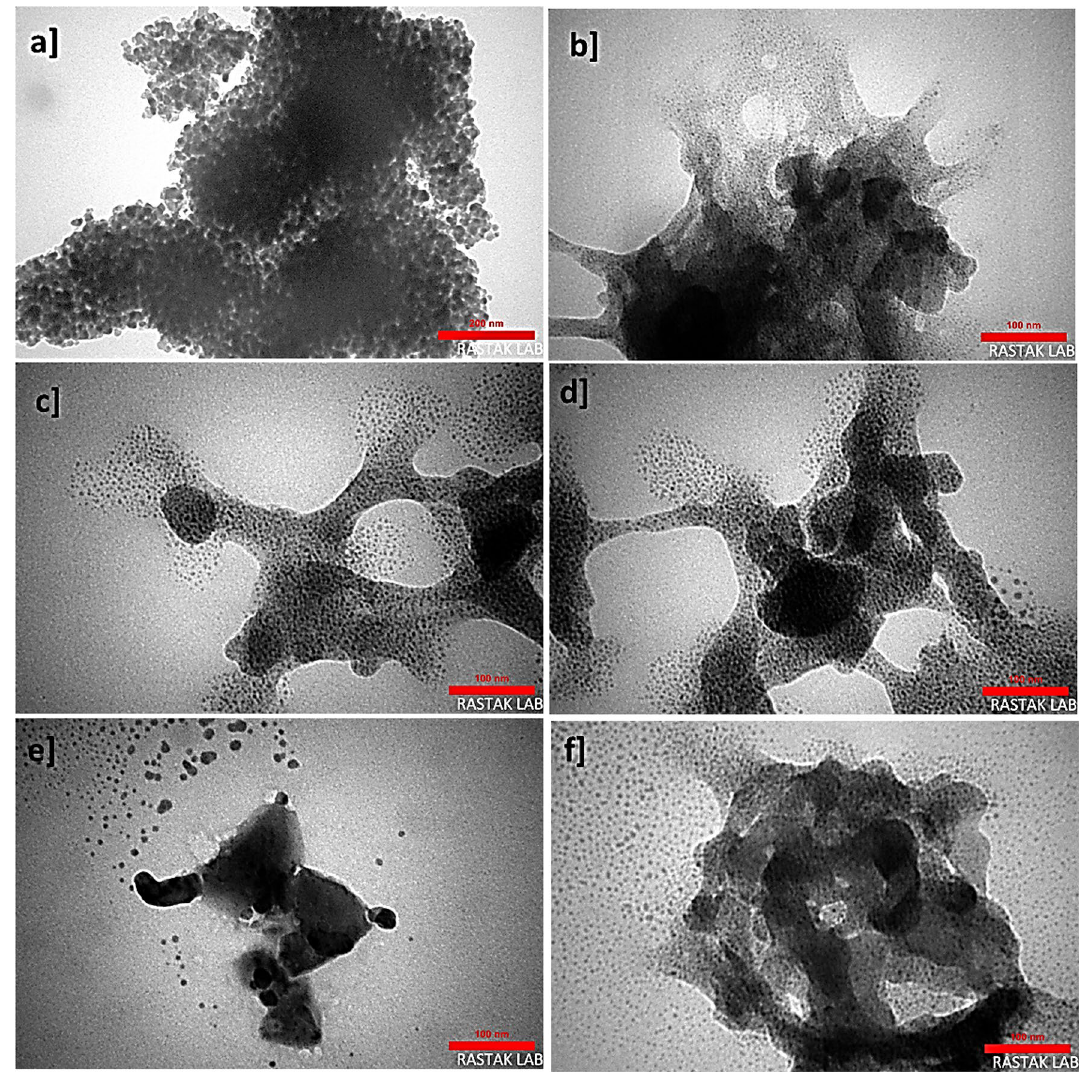
Figure 8. TEM images of ZnTPP/Cu-NPs (3) in the scale of 100 nm ( a , e ), ZnTPP/Cu-NPs(3) in the scale of 50 nm ( b ), ZnTPP/Cu-NPs-PAA(3) in the scale of 100 nm ( c ), and ZnTPP/Cu-NPs-PAA(3) in the scale of 200 nm ( d